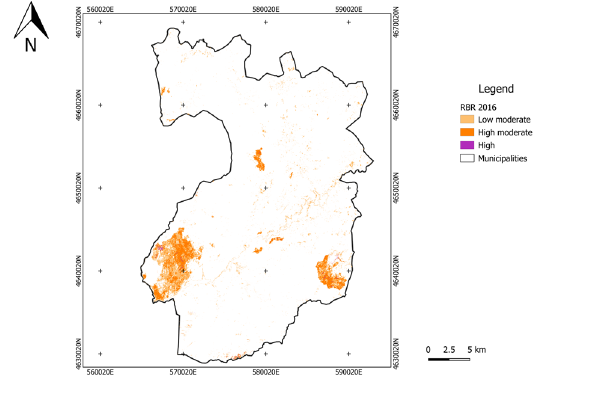
Figure 3. Burn severity levels by RBR 2016